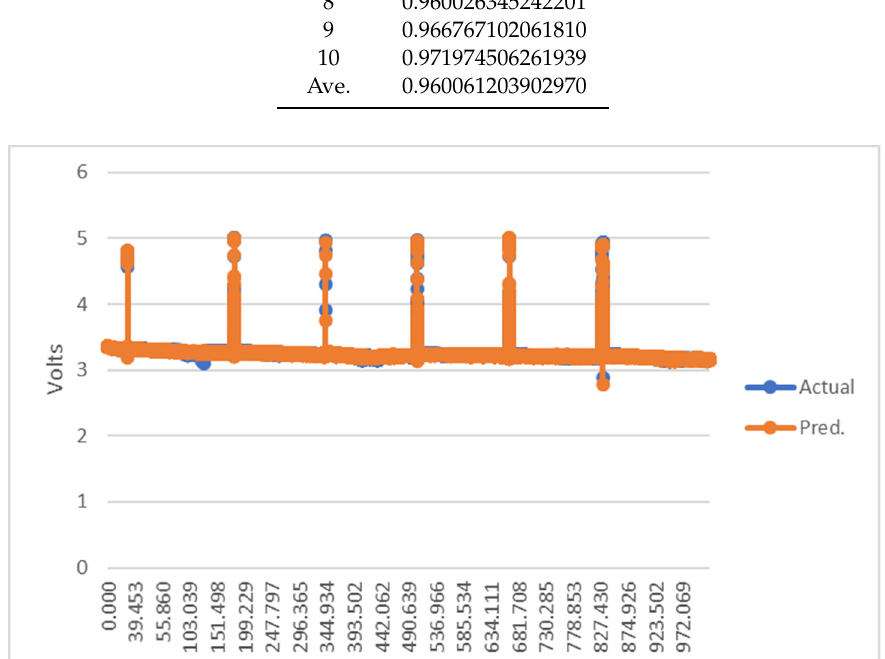
Figure 10. Actual values and predicted values.